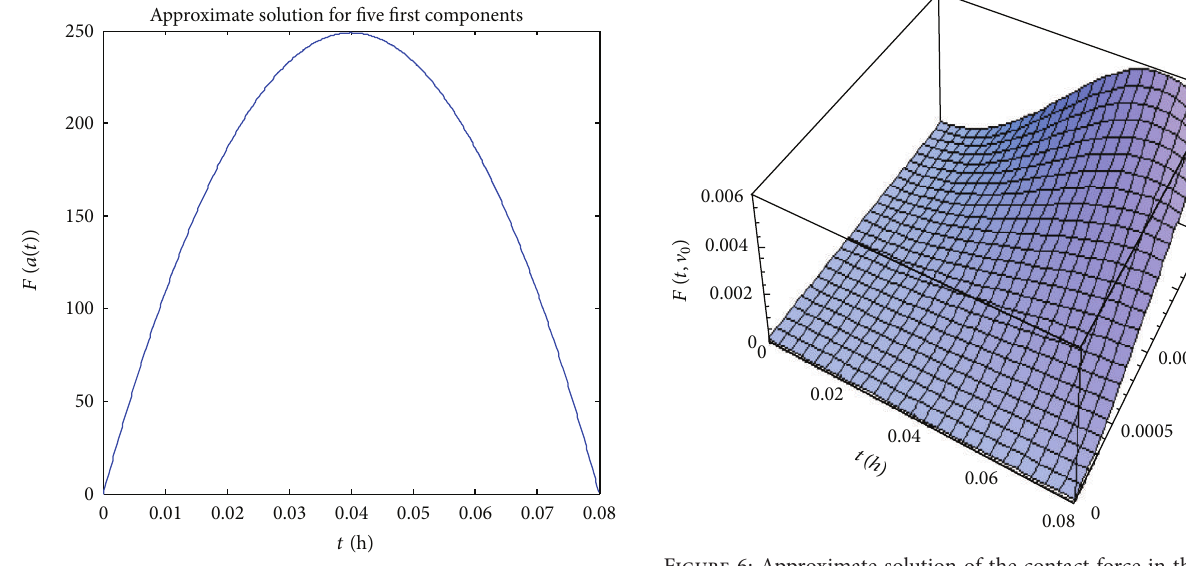
Figure 6: Approximate solution of the contact force in the elastic indentation phase equation (27) for 𝛽 = 2